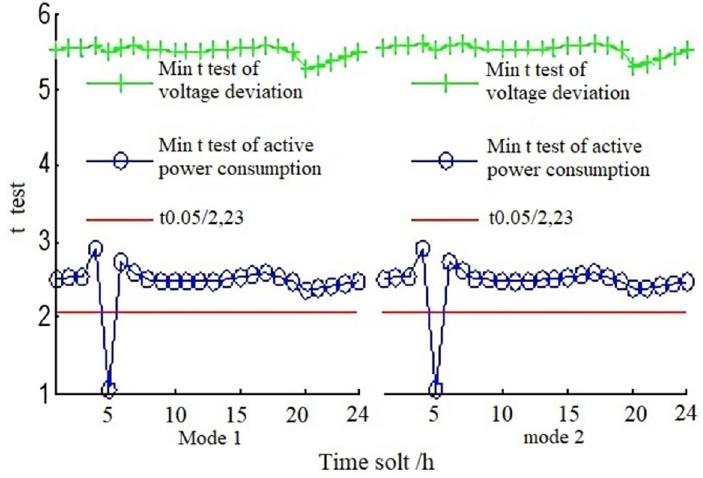
Fig 6. T-test diagram of voltage deviation and active power consumption of IEEE14